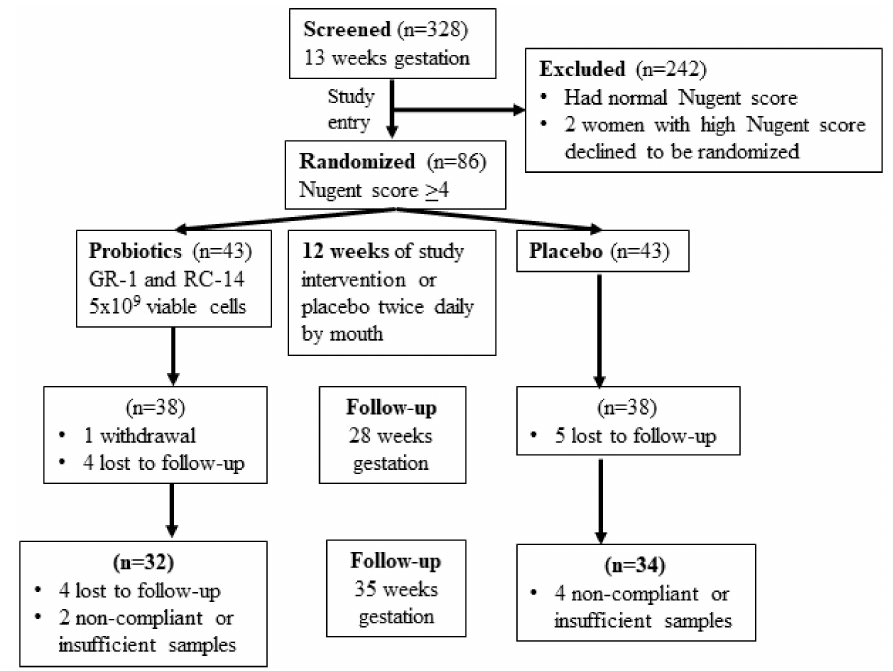
Figure 1. Consort flow chart of pregnant women enrolled in the